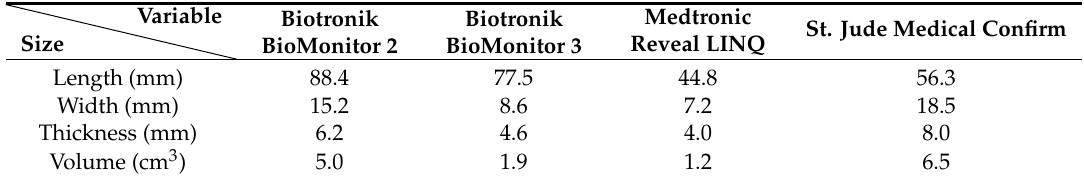
Table 2. Implantable loop recorder (ILR)